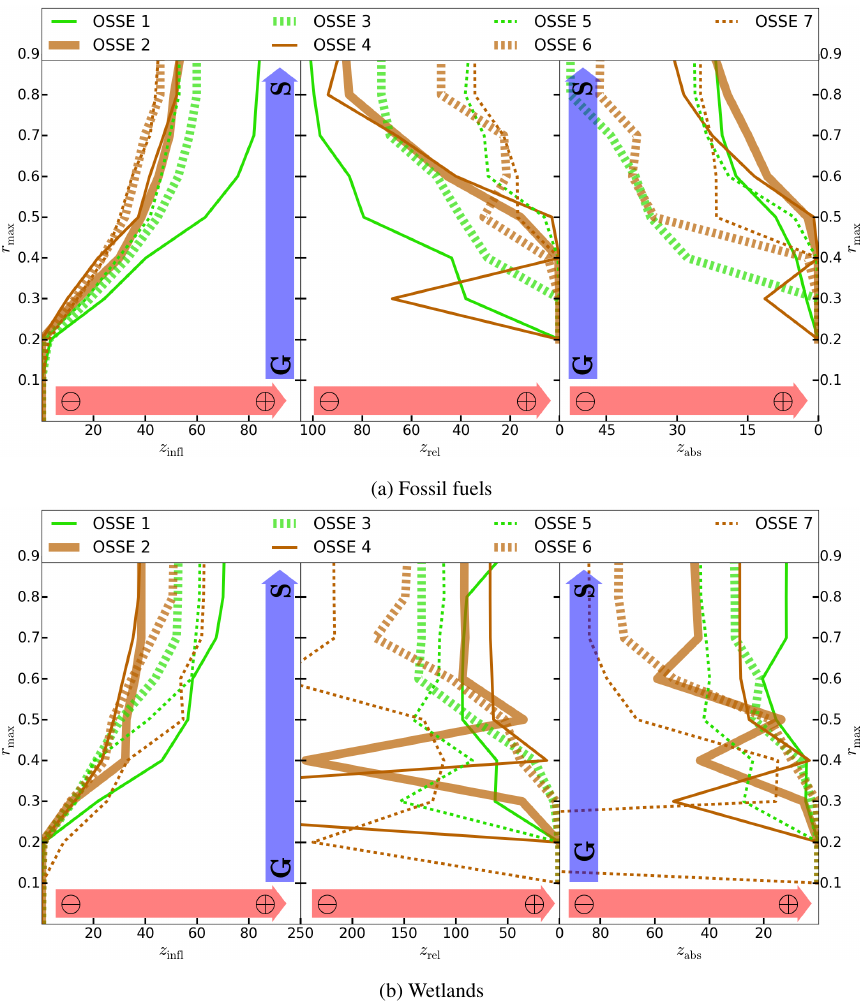
Figure 5. Score comparison on fossil fuel (up) and wetland (bottom) regions for all OSSEs along correlation thresholds r max of region grouping (see details in Sect. 4.2). Left: influence correlation z infl profile. Centre: relative score z rel correlation profile. Right: absolute score z abs correlation profile. The red arrows depict the direction from lowest scores to best ones. The blue arrows denote the direction of grouping, from all grouped (“G”, r max = 0) to all separated (“S”, r max = 1). The OSSEs are indexed along Table 1 numbering. Thin (resp. thick) lines stand for correct (resp. perturbed) subtotal emissions. Green (resp. brown) lines depict correct (resp. perturbed) emission distributions. Solid (resp. dotted) lines represent correct (resp. perturbed) transport. As in Sect. 4.2, the scores are noted in